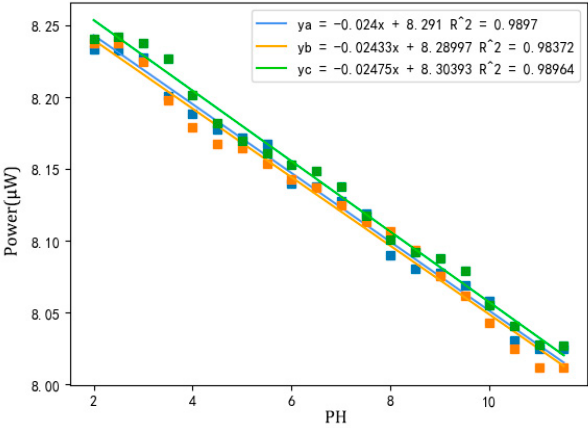
Figure 7. Power–pH curve of three optimized pH sensors.